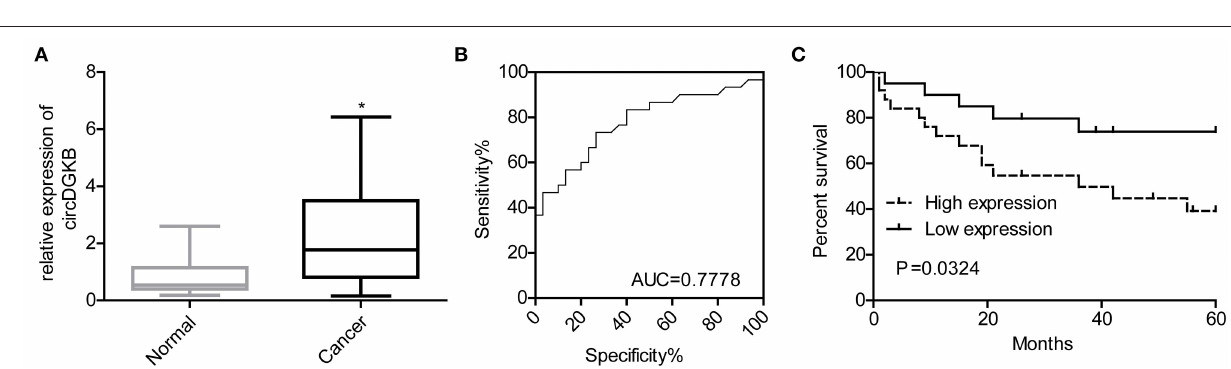
FIGURE 8 | miR-873 inhibited NB progression by targeting GLI1. (A) Proliferation of SK-N-SH cells was detected by CCK-8 assay. (B) Apoptosis of SK-N-SH cells was detected by flow cytometry. (C) Cell cycle of SK-N-SH cells was assessed by flow cytometry. (D) Cell invasion and (E) migration were determined by transwell experiment and wound healing assay in SK-N-SH cells. (* P < 0.05, vs. mimic-NC + Lentiv-NC group, # P < 0.05, vs. mimic-miR-873 + Lentiv-NC group).